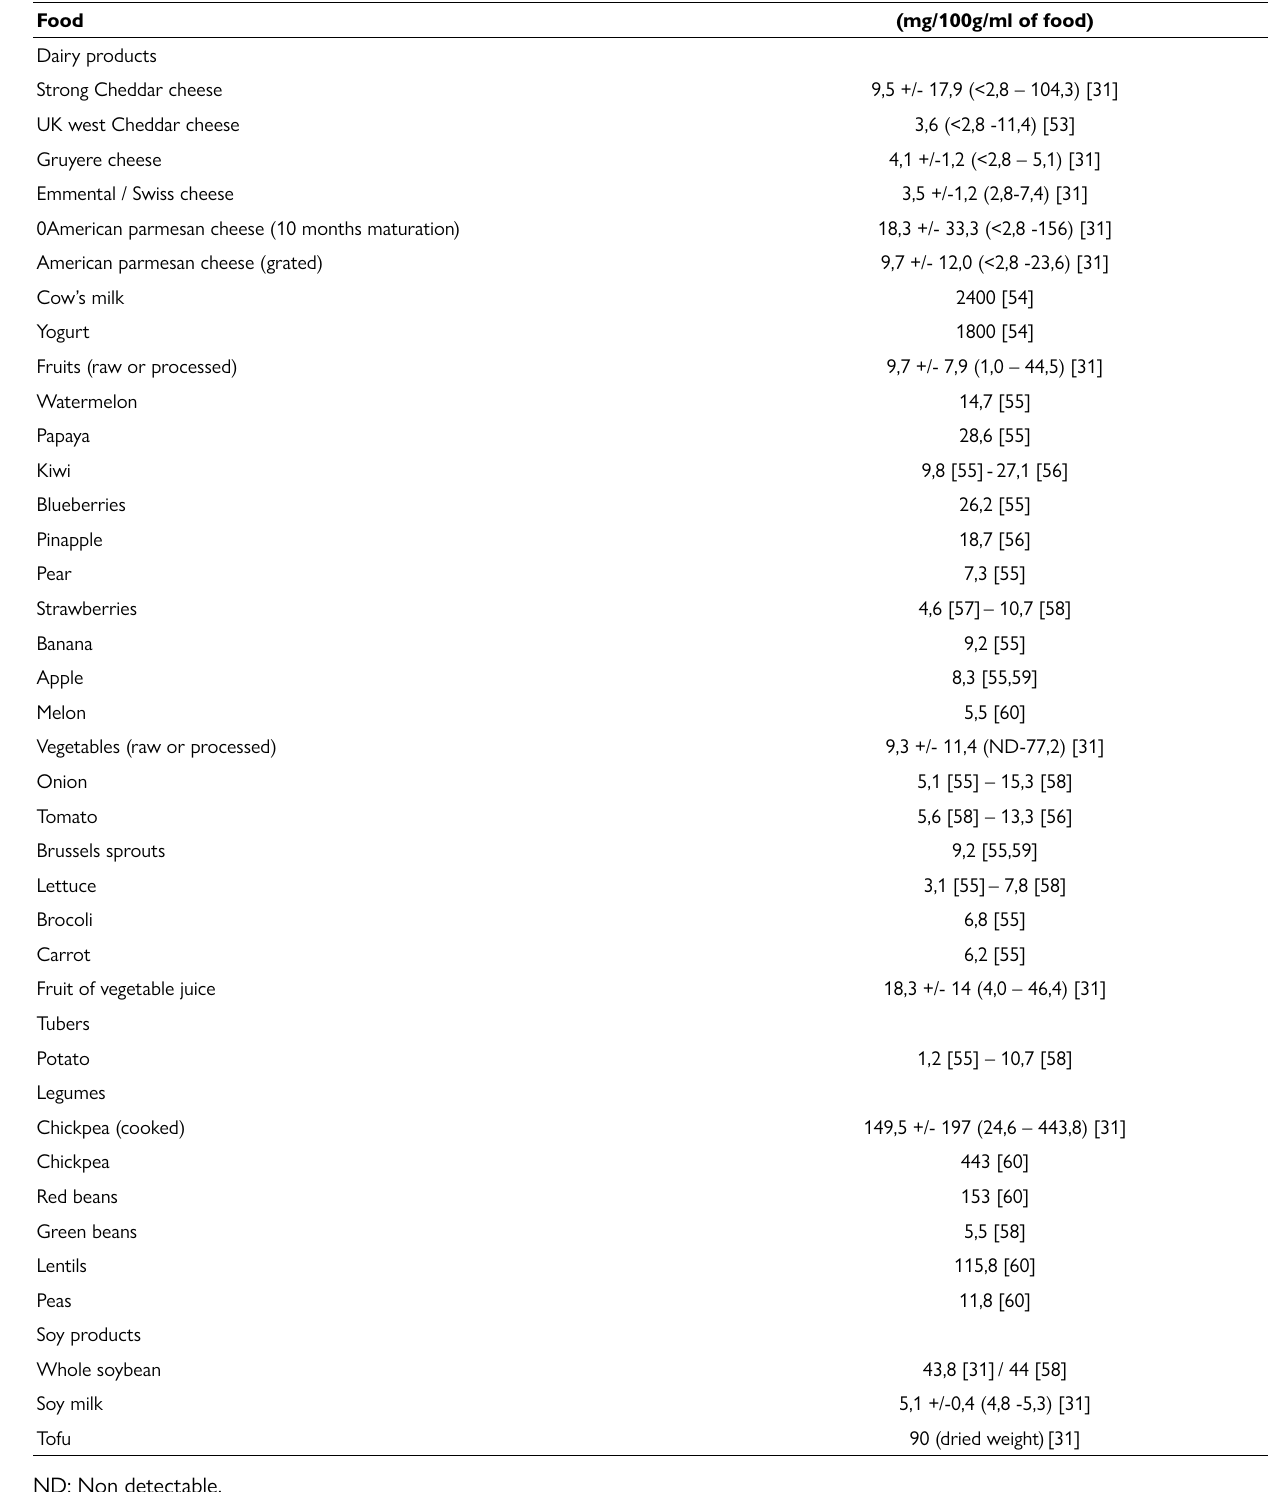
Table 1. Free galactose content of some foods.